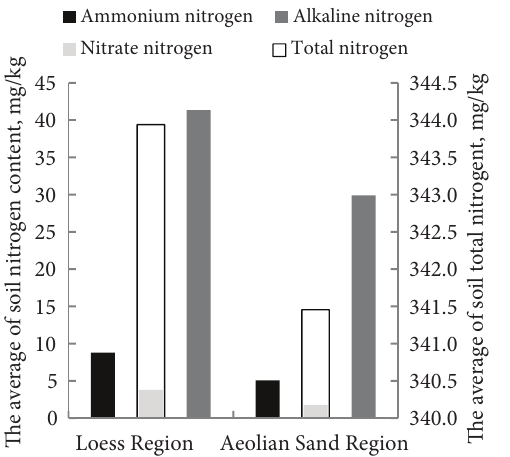
Figure 7. The comparison of different forms of nitrogen content in the loess region and the aeolian sand region